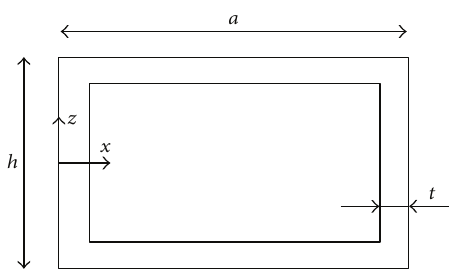
Figure 16: Cross-section of the hollow-rectangular box